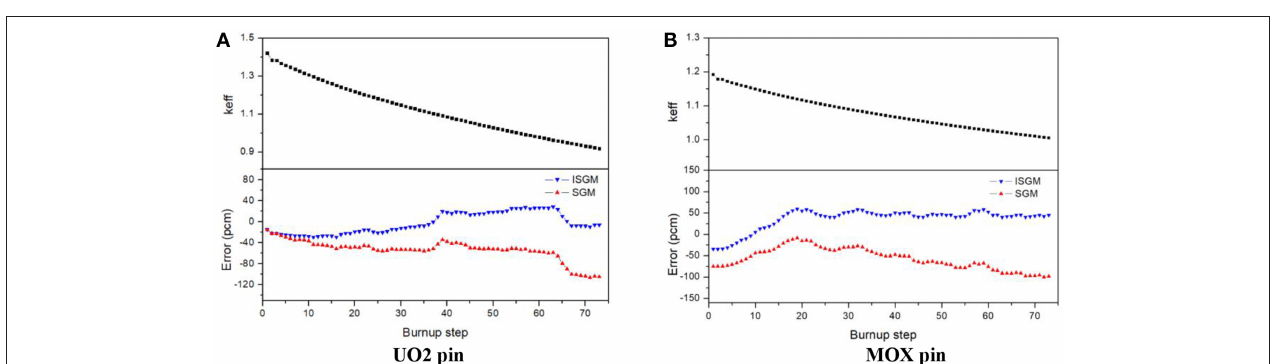
Frontiers in Energy Research |